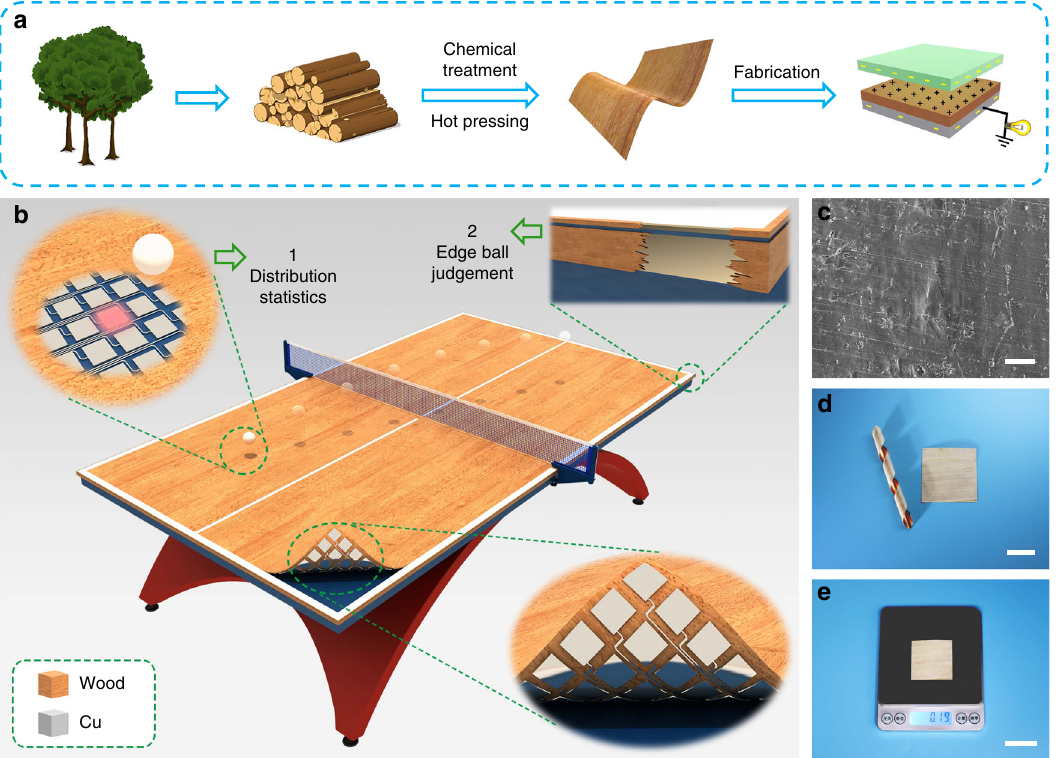
Fig. 1 Fabrication and schematic of the fl exible wood-based TENG and smart ping-pong table. a Diagram of the process for fabricating a fl exible W-TENG. b Schematic illustration of the natural wood-based smart ping-pong table. c Scanning electron microscopy (SEM) image of the treated wood surface.